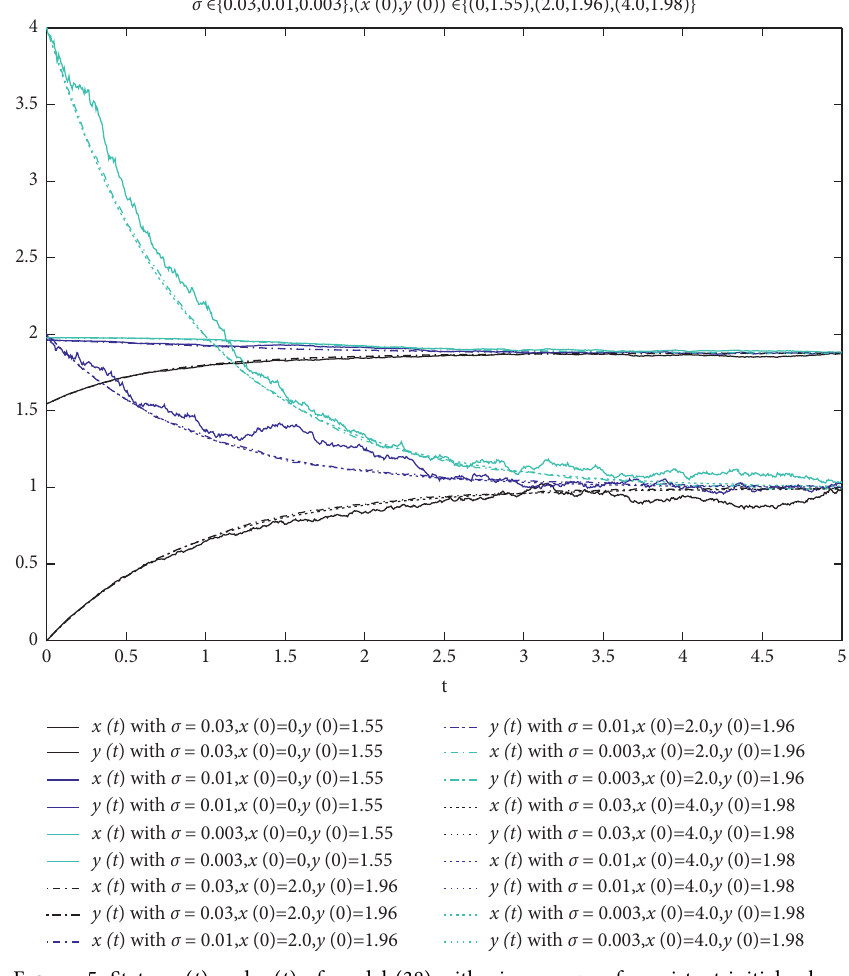
Figure 5: States x ( t ) and y ( t ) of model (38) with nine groups of consistent initial